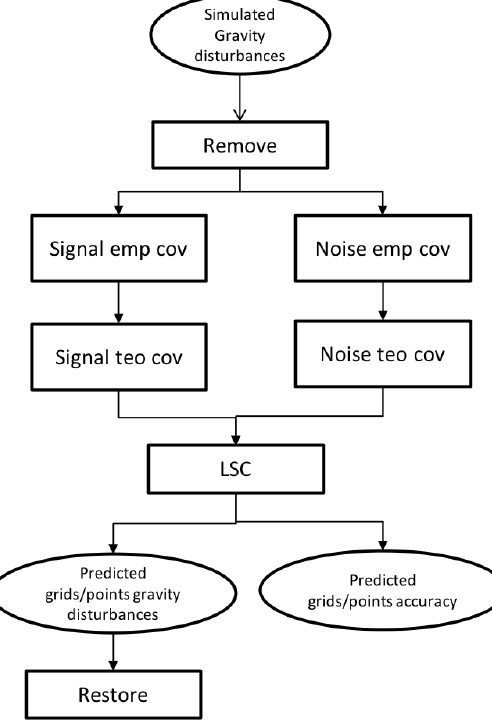
Figure 2. The proposed processing scheme to estimate the final predicted accuracy of a simulated airborne